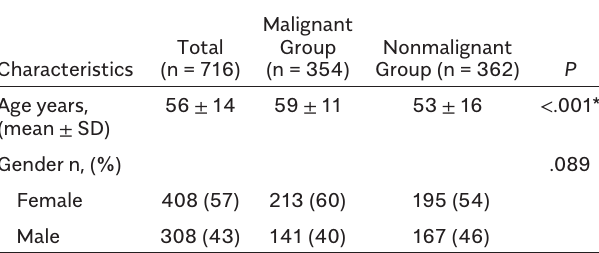
Table 1. Demographic Characteristics in the Patients with MP